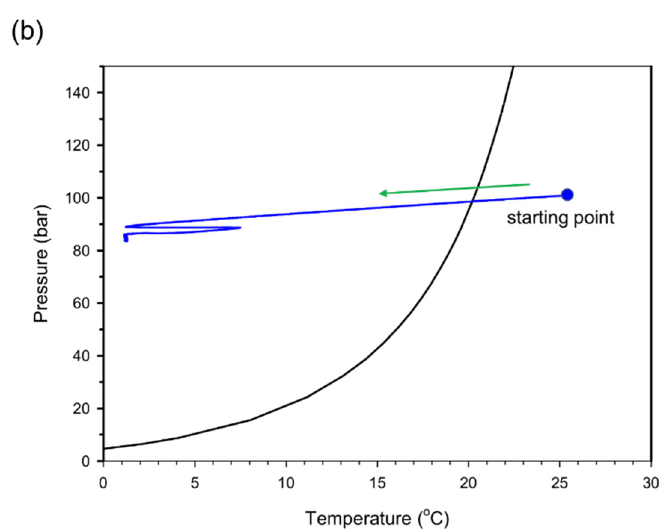
Figure 1. (a) Schematic diagram of the experimental system. The synthetic natural gas (7) was injected into the reactor (1) through a booster (6). The experimental temperature was controlled by an external chiller (8), while the temperatures (4), the pressures (3) and the torques of a magnetic drive (2) were recorded in a data acquisition computer (5). (b) Temperature profiles of the experimental measurements starting at 298.2 K and 100